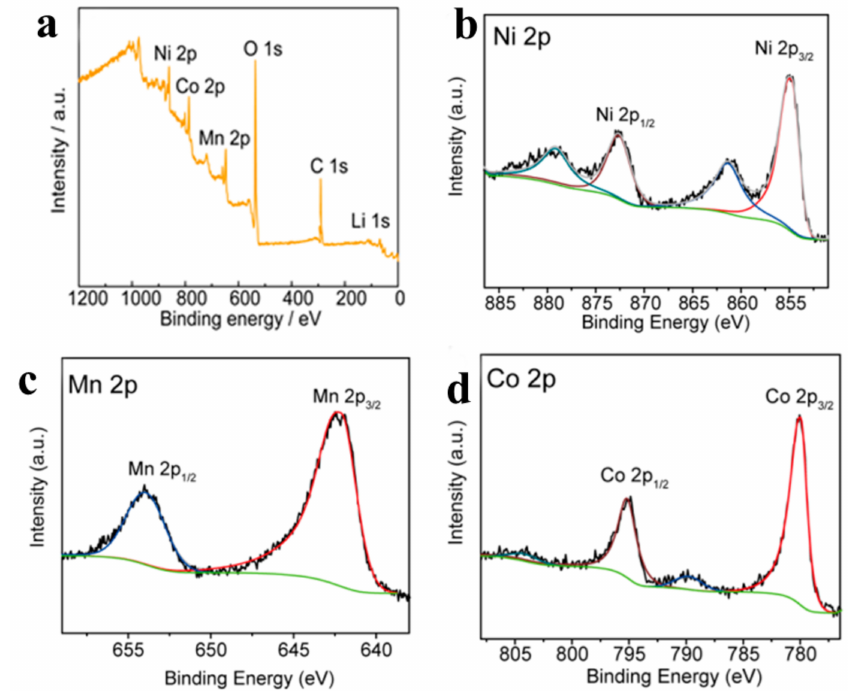
Figure 4. XPS spectra of LNCM-1: ( a ) full XPS spectra, ( b ) Ni 2p, ( c ) Mn 2p, ( d ) Co 2p.